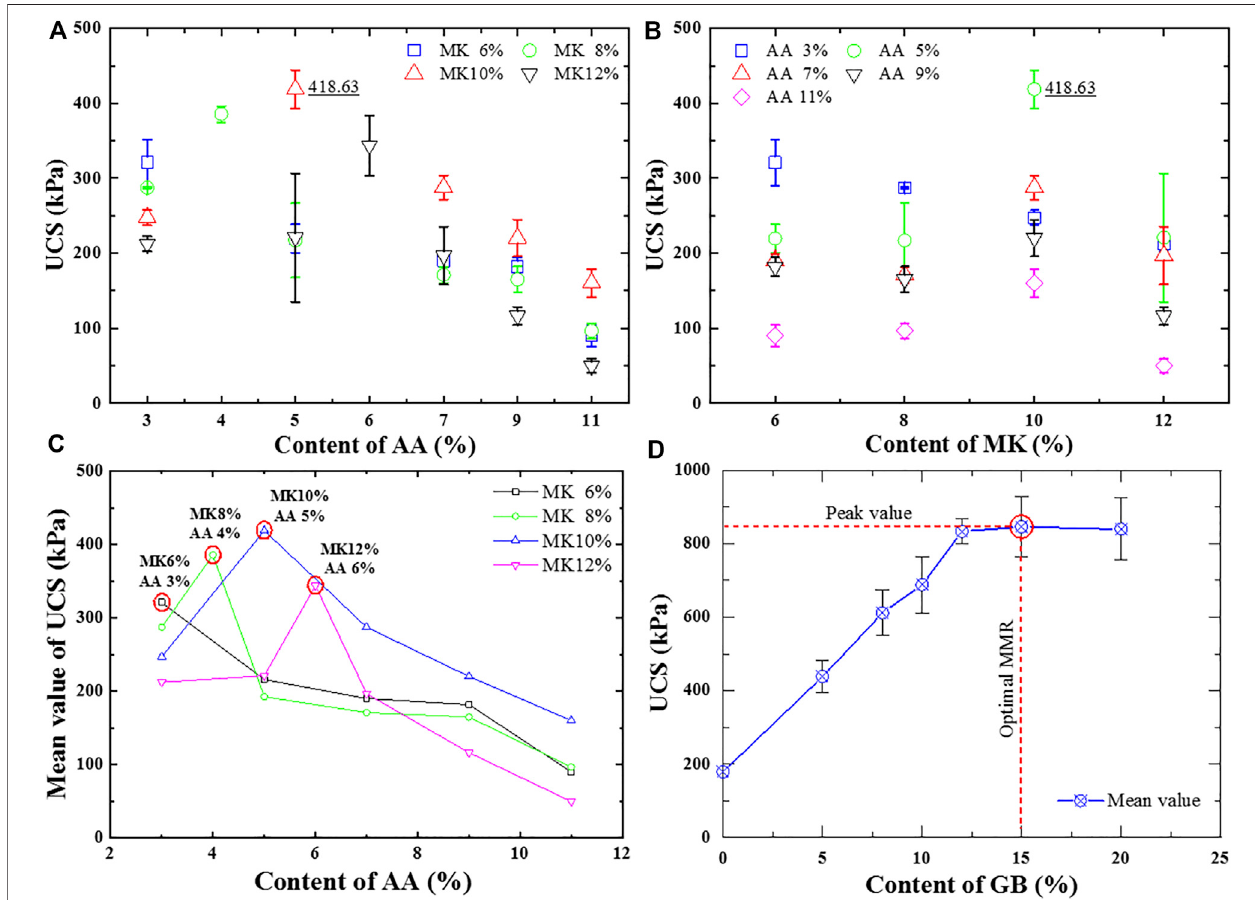
FIGURE 1 | The UCS of GSC specimens with different mixing ratios of